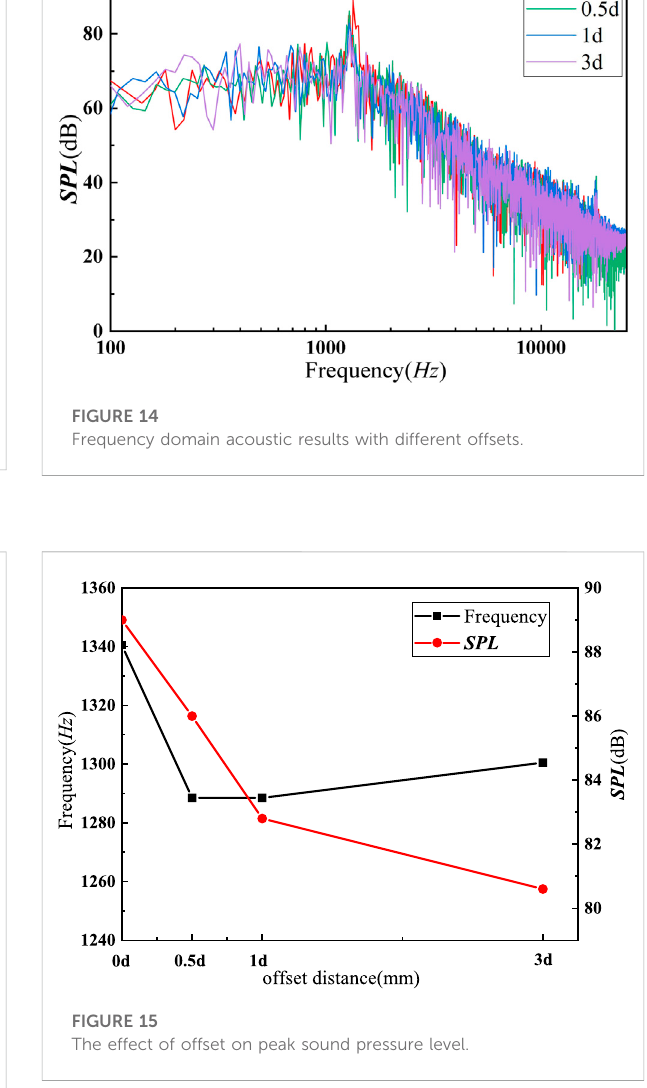
distance D = 0d the pressure on the upper and lower surfaces of the airfoil shows symmetric changes. With the increase of offset distance in the region near the leading edge (0.014 < x/c < 0.3), the pressure gradually decreases and with a asymmetric distribution. This may be caused by the fact that with the increase of the offset distance, the higher the fl ow velocity interacts with the leading edge of the airfoil. When the offset distance increases, the airfoil gradually get out of the vortex street in fl uence area, and the fl ow fi eld around the body is dominated by the velocity fi eld without cylindrical disturbance. The pressure distribution at the leading edge of airfoils along the spanwise is presented in Figure 12. The pressure in the center of the leading edge is affected by the vortex shedding dramatically. The pressure difference in the center of the leading edge gets its maximum for about 1,300 Pa by comparing D = 0d and D = 3d. This difference decreases with the increase of offset distance D.